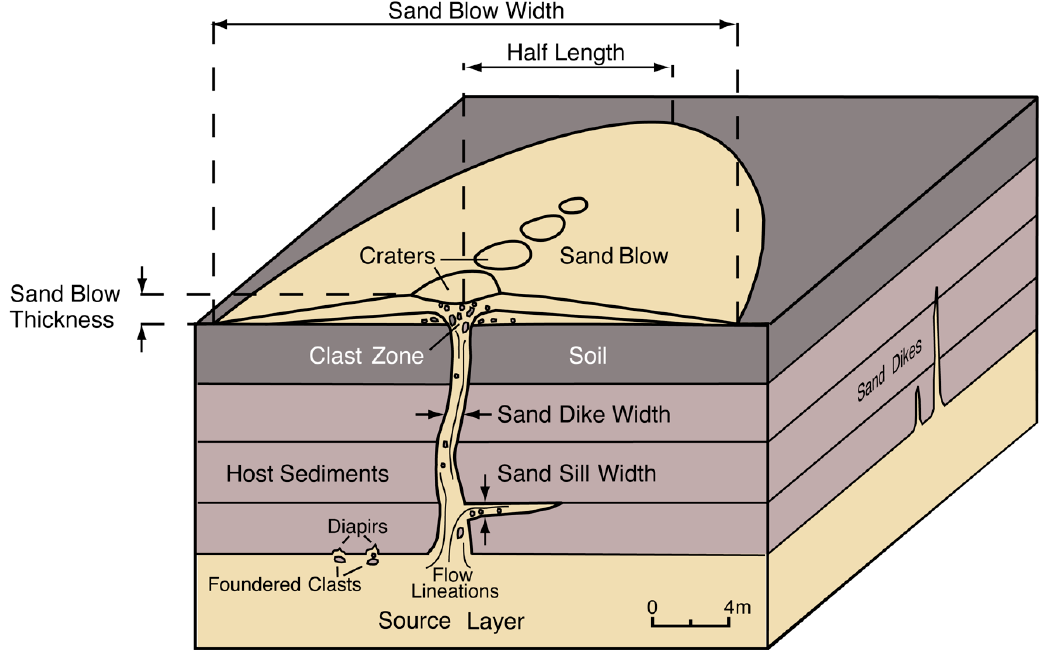
Figure 3. Block diagram showing relationship between the liquefied layer and overlying liquefaction features, including intrusive sand dikes and sills and an extrusive sand blow [51].